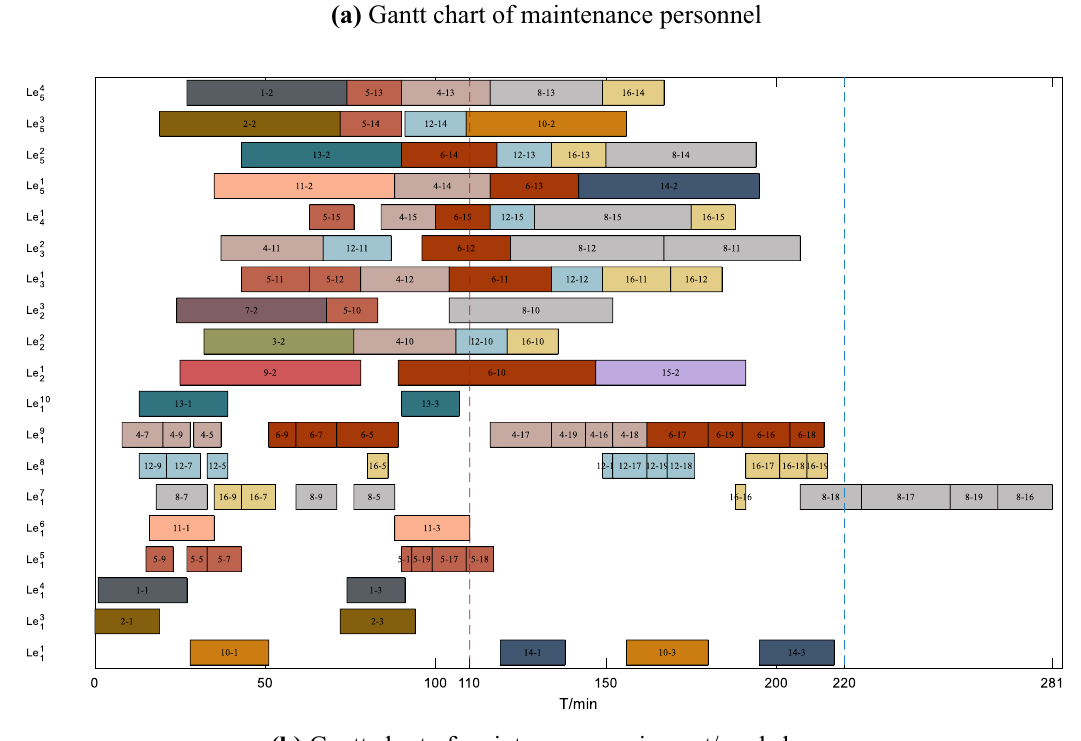
Fig. 13 Baseline schedule for 16 carrier-based aircraft